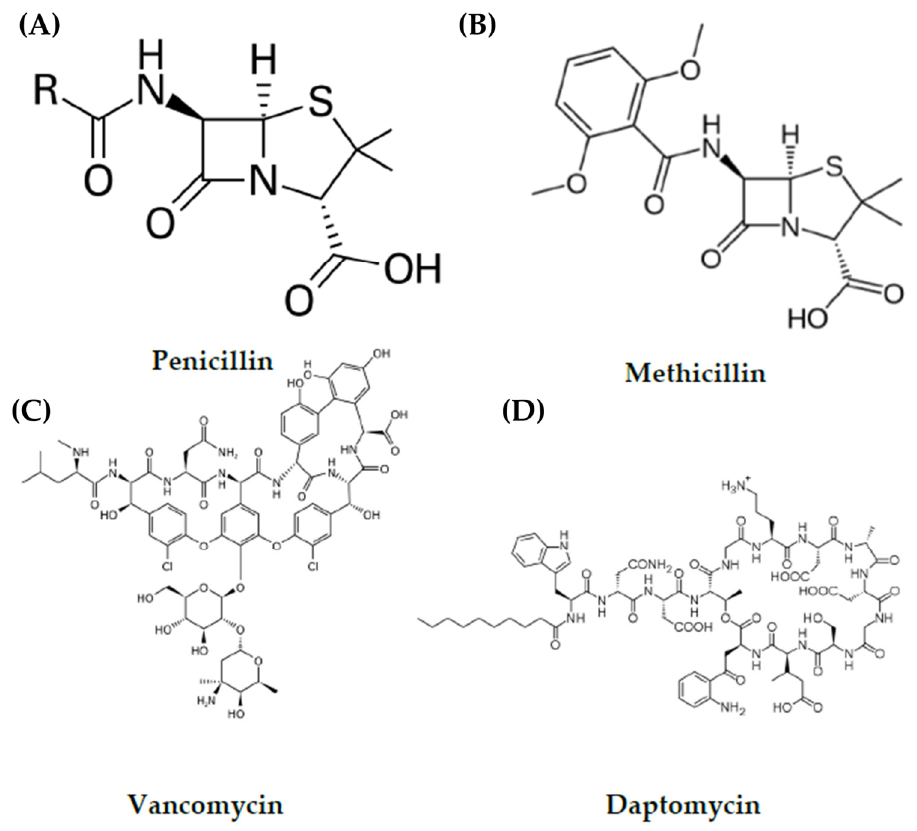
Figure 1. Structure of antibiotics used against S. aureus . ( A ) Penicillin G. ( B ) Methicillin. ( C ) Vancomycin. ( D ) Daptomycin.